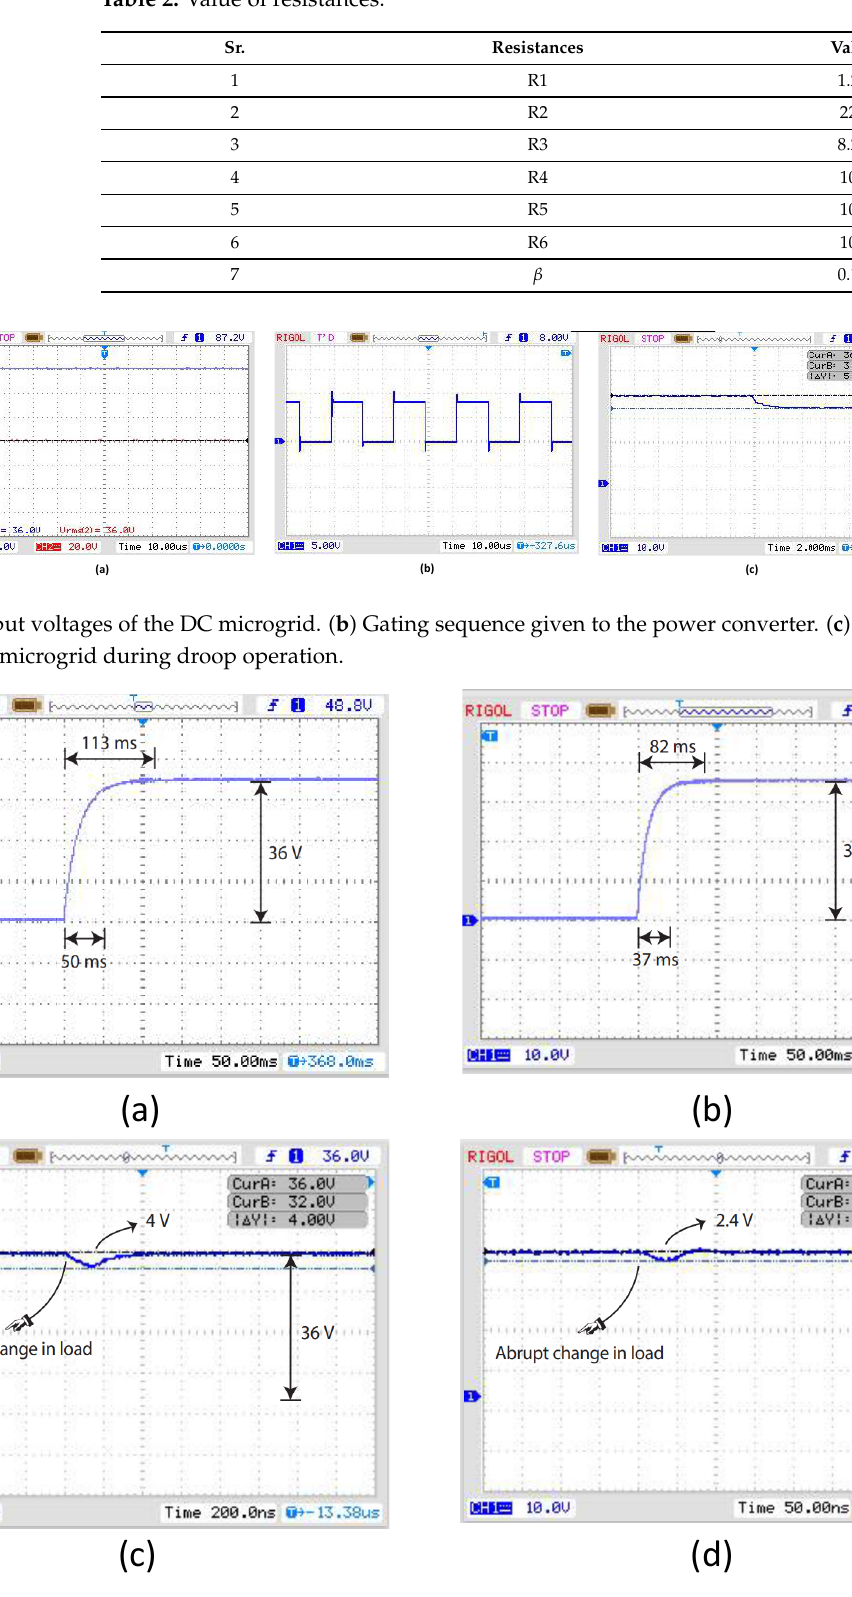
Figure 7. ( a ) Step response of PI compensated droop controller. ( b ) Step response of the proposed controller. ( c ) Voltage dip observed while connecting a resistance of 56 Ω in parallel to the existing 100 Ω in the PI compensated droop controller. ( d ) Voltage dip observed while connecting a resistance of 56 Ω in parallel to the existing 100 Ω in the proposed